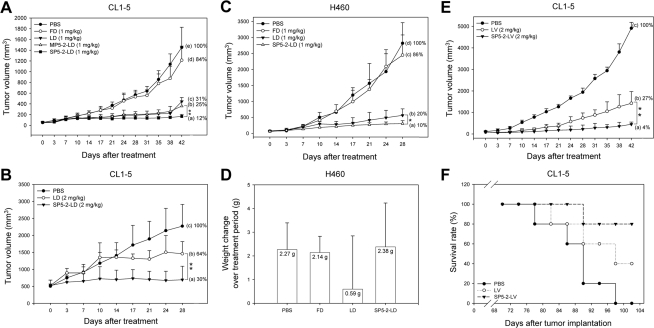
Treatment of SCID mice bearing human lung cancer xenografts with SP5-2-LD or SP5-2-LV.(A) Median tumor volume over time in mice treated with PBS, FD, LD, MP5-2-LD, or SP5-2-LD. Tumor growth was markedly suppressed in the SP5-2-LD treated group. SP5-2-LD has higher therapeutic efficacy than LD and MP5-2-LD (n = 6 in each group; **P<0.01). (B) Mice bearing size-matched CL1-5-derived lung cancer with tumor size of approximately 500 mm3 were treated with SP5-2-LD, LD, or PBS (n = 6 in each group, **P<0.01). (C) Mice bearing H460-derived lung cancer were treated with SP5-2-LD, LD, FD, or PBS (n = 6 in each group, *P<0.05). (D) The effects of different treatments on change in body weight over the treatment period (n = 6 in each group). (E) Mice bearing CL1-5-derived lung cancer were treated with SP5-2-LV, LV, or PBS (n = 6 in each group; **P<0.01). (F) A Kaplan-Meier survival curve showed longer lifespan of mice treated with SP5-2-LV than those treated with LV and PBS (n = 5 in each group).